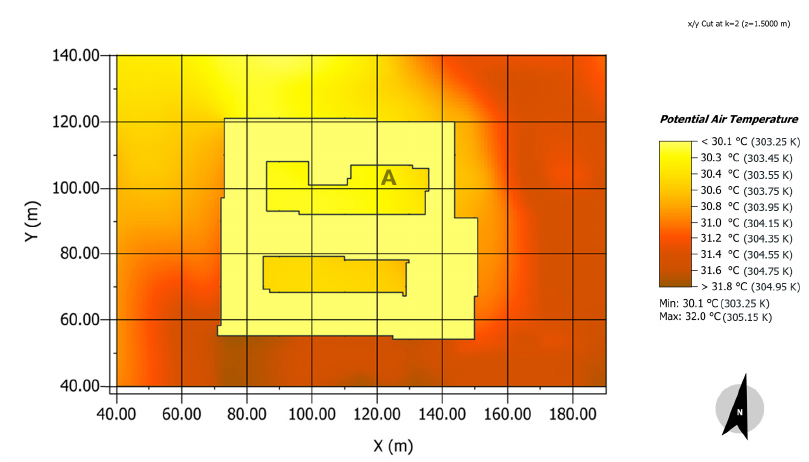
Figure 3. Potential air temperature at 16:00 on August 9, 2018 in the modelled situation. The model building walls are marked with black line. As there is a section made at the 1.5 m height, a temperature of below 30.1 °C refers to the inner space of the adjacent structures. The atrium is marked with the letter A. Figure by authors.